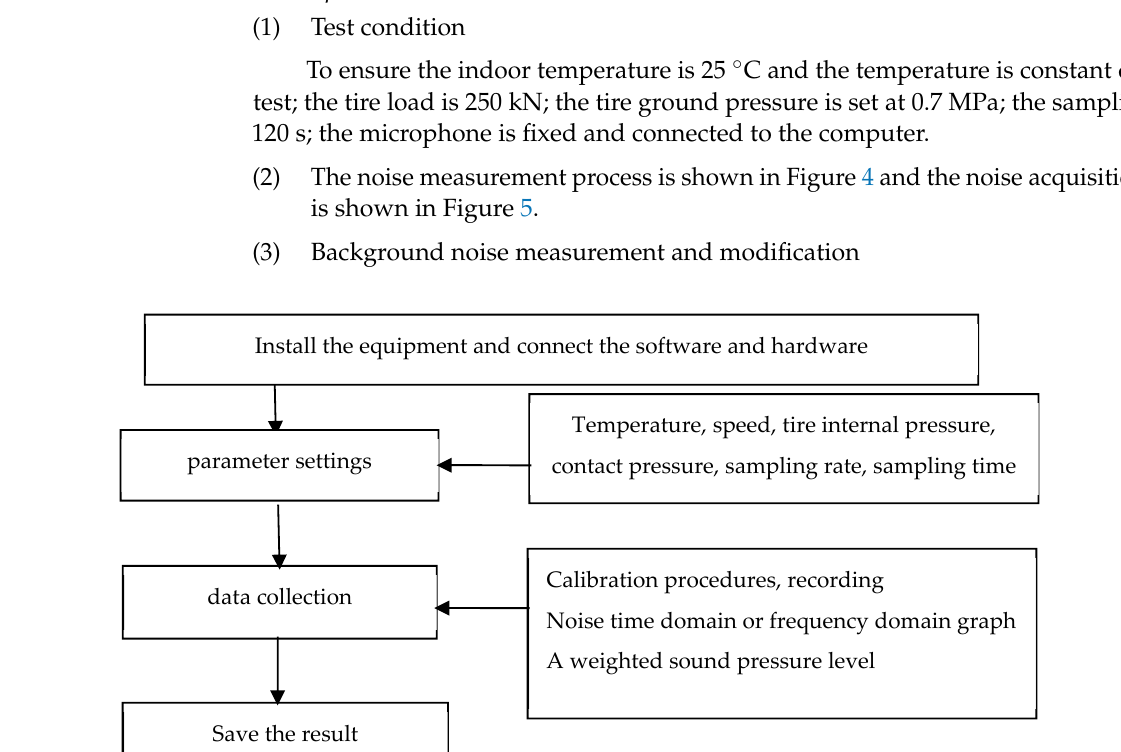
Figure 4. Indoor noise test procedure.